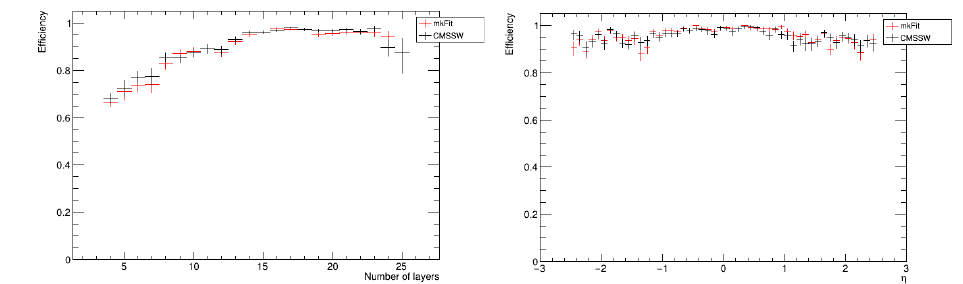
Figure 2. E ffi ciency for mkFit and CMSSW algorithms as a function of the number of crossed layers and the pseudorapidity η of the simulated particle, for simulated particles with p T > 0 and p T > 0.9 GeV, respectively. The sample used are t ¯ t events with an average PU of 50. The track building e ffi ciency is defined as the ratio of the number of simulated tracks that can be matched to a reconstructed track to the number of simulated particle tracks that can be matched to an initial iteration seed. The matching criterion is that more than 75% of the reconstructed track or seed hits originates from the simulated